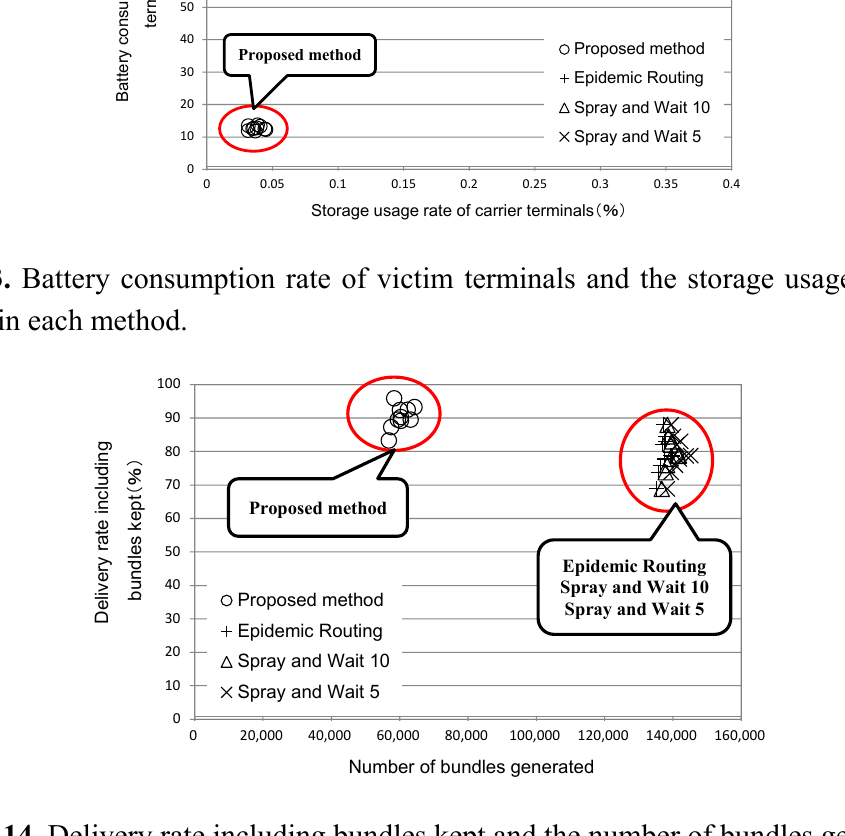
Figure 14. Delivery rate including bundles kept and the number of bundles